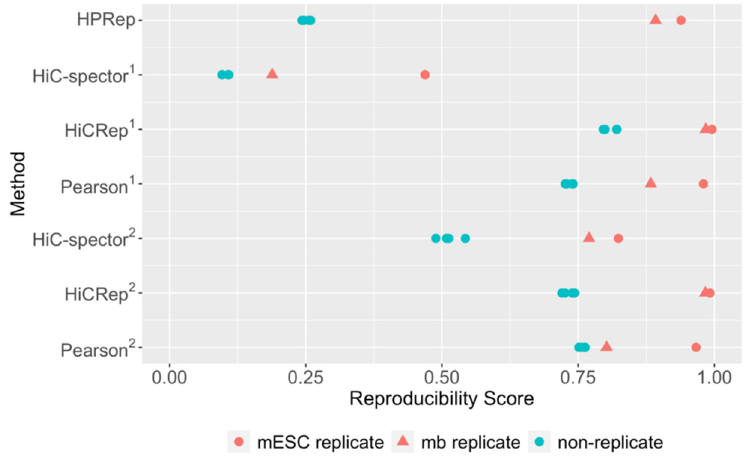
Figure 3. Comparison of methods in mouse PLAC-Seq datasets. HPRep compared to Hi-C specific methods HiC-Spector and HiCRep as well as Pearson correlation. (1) All methods using bin pairs in the AND and XOR sets. (2) Methods other than HPRep using all bin pairs in the AND, XOR and NOT sets. PLAC-Seq dataset consisted of two mESC and two mouse brain replicates.